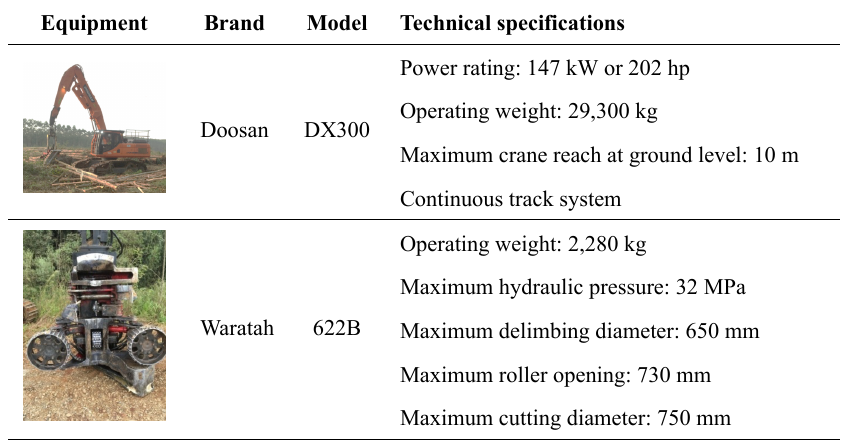
Harvester machine and processing head